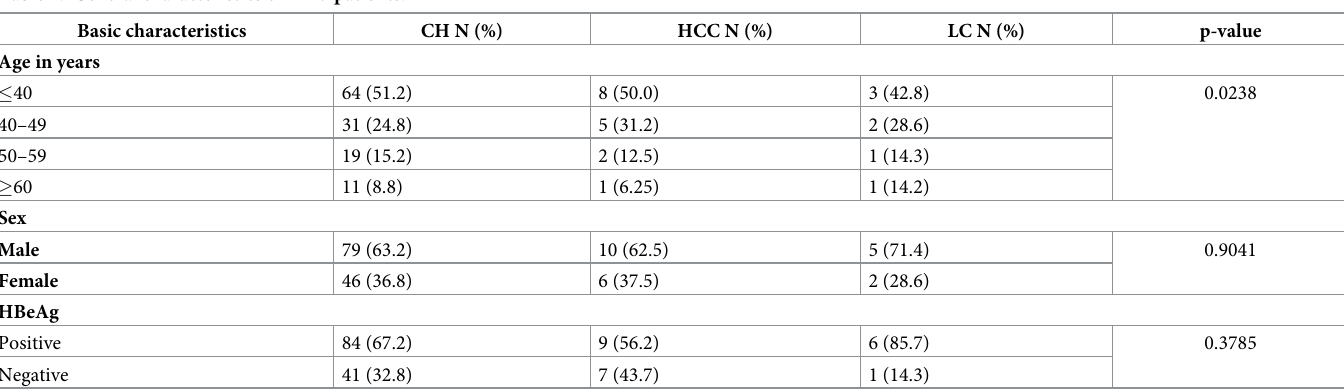
Table 1. General characteristics of HBV